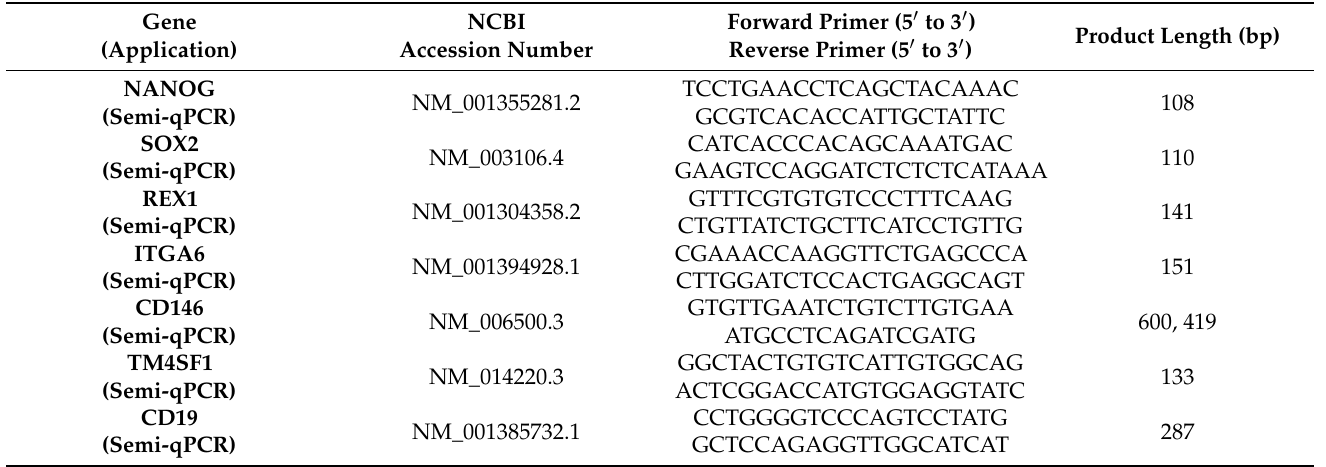
Table 1. Primer sequences of the genes used in this